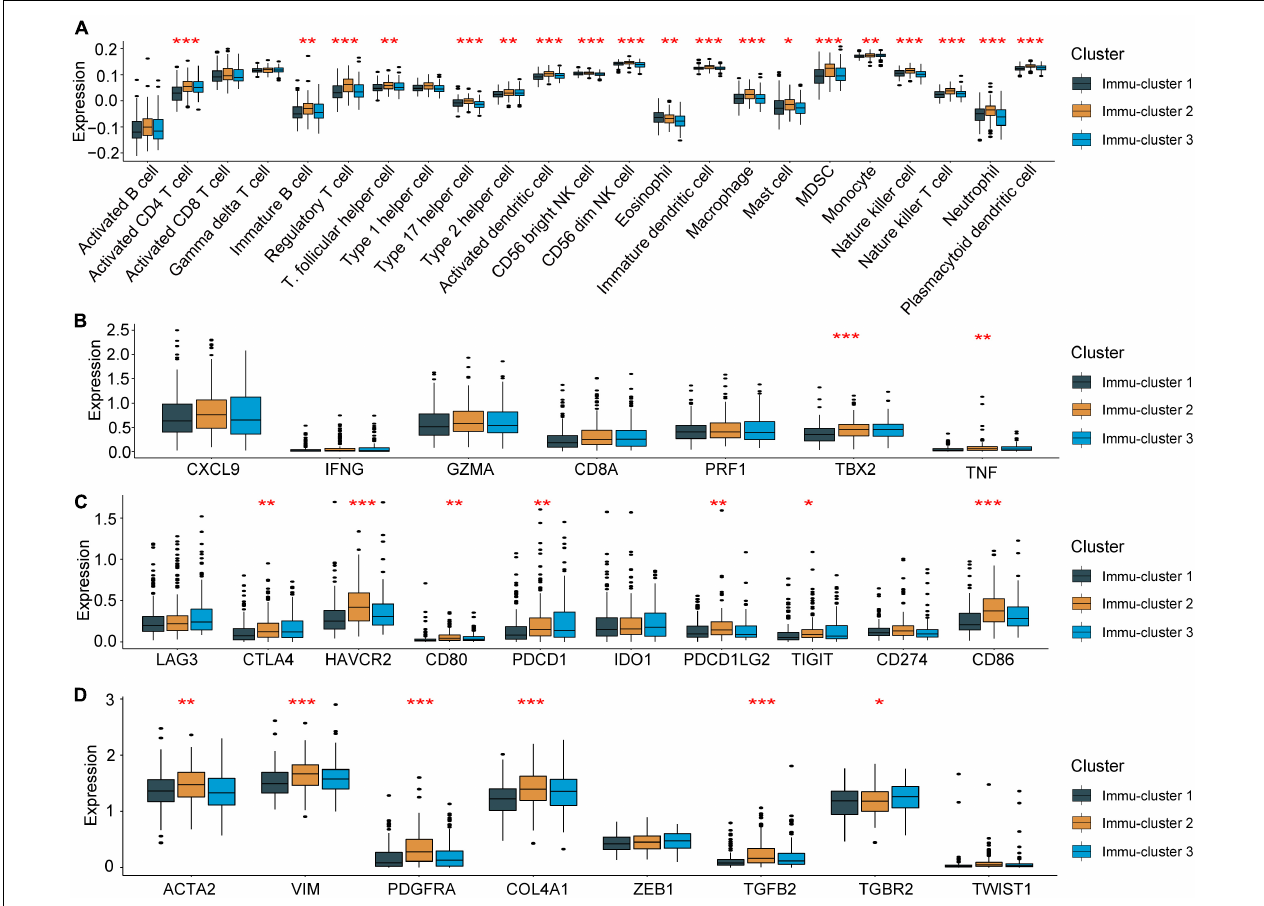
FIGURE 7 | Association between the expression of m 5 C regulators and immunoregulation in the TME. (A) Differences in immune cell infiltration in the three Immu-clusters. (B) Comparison of immune-related cytokine expression in the three Immu-clusters. (C) Comparison of the transcription of immune checkpoint genes in the three Immu-clusters. (D) Immu-clusters involved in the transcription of the TGF- β /EMT pathway. * p < 0.05, ** p < 0.01, *** p < 0.001.